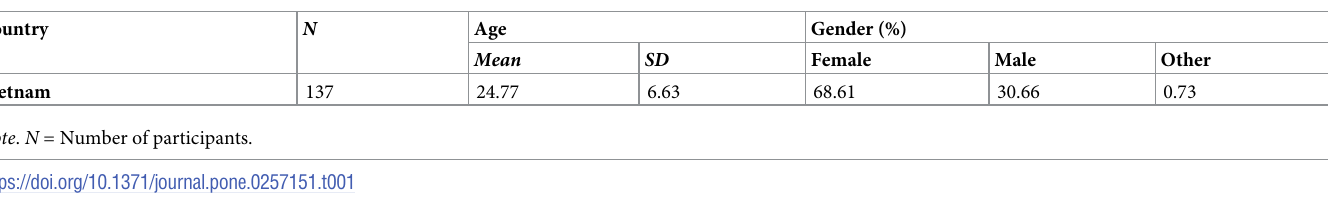
Measurement invariance test and measurement alignment. Prior to analyses, we tested for measurement invariance of PSS-10, Coronavirus Concerns, and Trust in the Country’s Institutions. The analyses were performed in R version 4.0.2 [45], using packages lavaan ver- ysis, we considered three models: one assuming a two-factor structure for PSS-10 (positive and negative, with the latter consisting of reversed items [48, 49]) and one-factor structure for Coronavirus Concerns and Trust across all countries (configural invariance), a second model with factor loadings and latent correlations constrained to be equal (metric invariance), and a third model with equal items’ intercepts in all groups (scalar invariance). We compared the configural invariance model with the metric invariance model, and then the metric invariance model with the scalar invariance model [50]. To determine whether measurement invariance was achieved, we used -.01 change in CFI, +.015 in RMSEA, and +.030 in SRMR, for metric invariance, and -.01 change in CFI, +.015 in RMSEA, and +.015 in SRMR, for scalar invariance [51]. Scalar measurement invariance, which is necessary for comparing means across various countries, was not achieved in all cases (see Table 2).